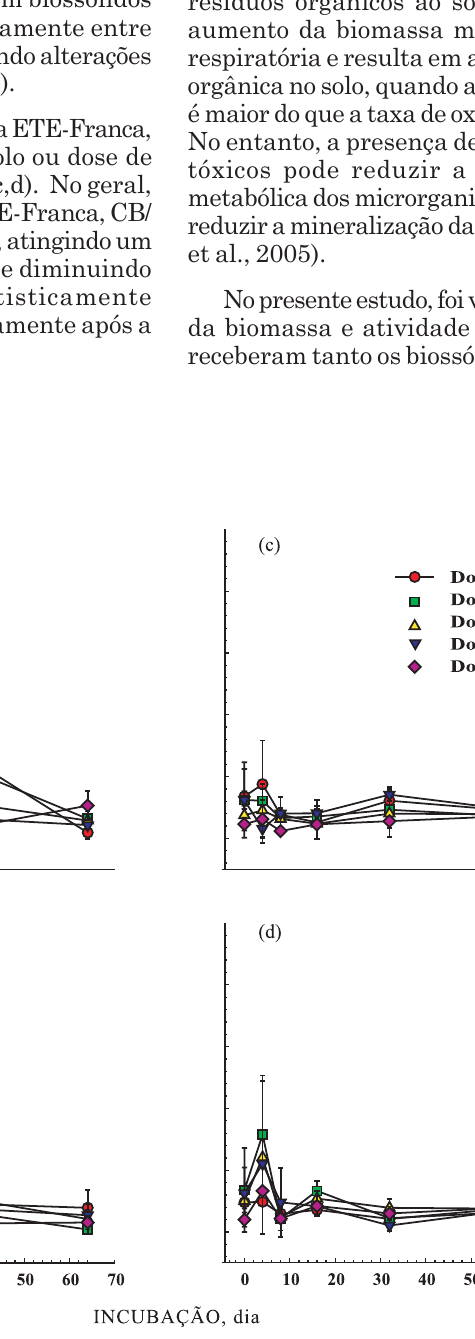
Figura 4. Variação do CB/C em solo arenoso (a, c) ou argiloso (b, d) tratado com biossólidos da ETE- org Barueri (a, b) ou ETE-Franca (c, d). Os dados são médias de 3 repetições ± desvio-padrão da